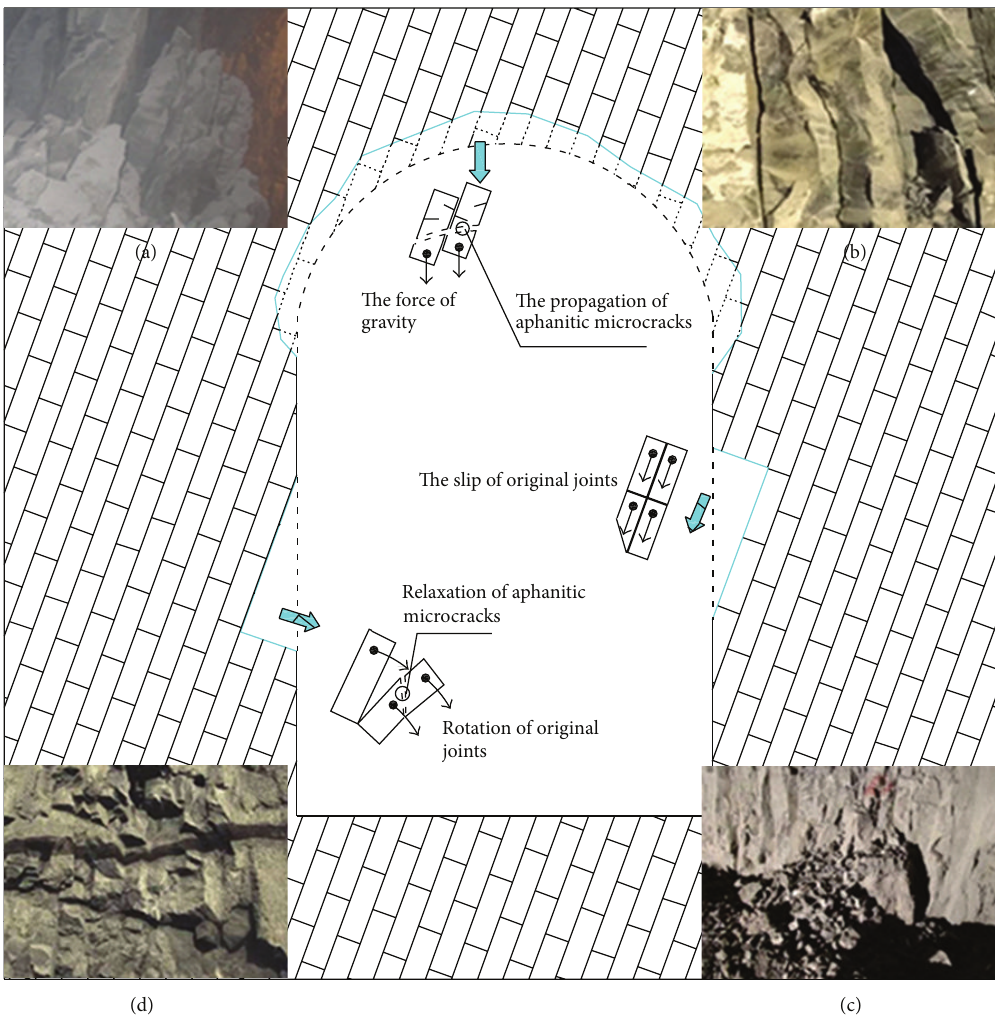
Figure 1: Failure modes of surrounding rock in the